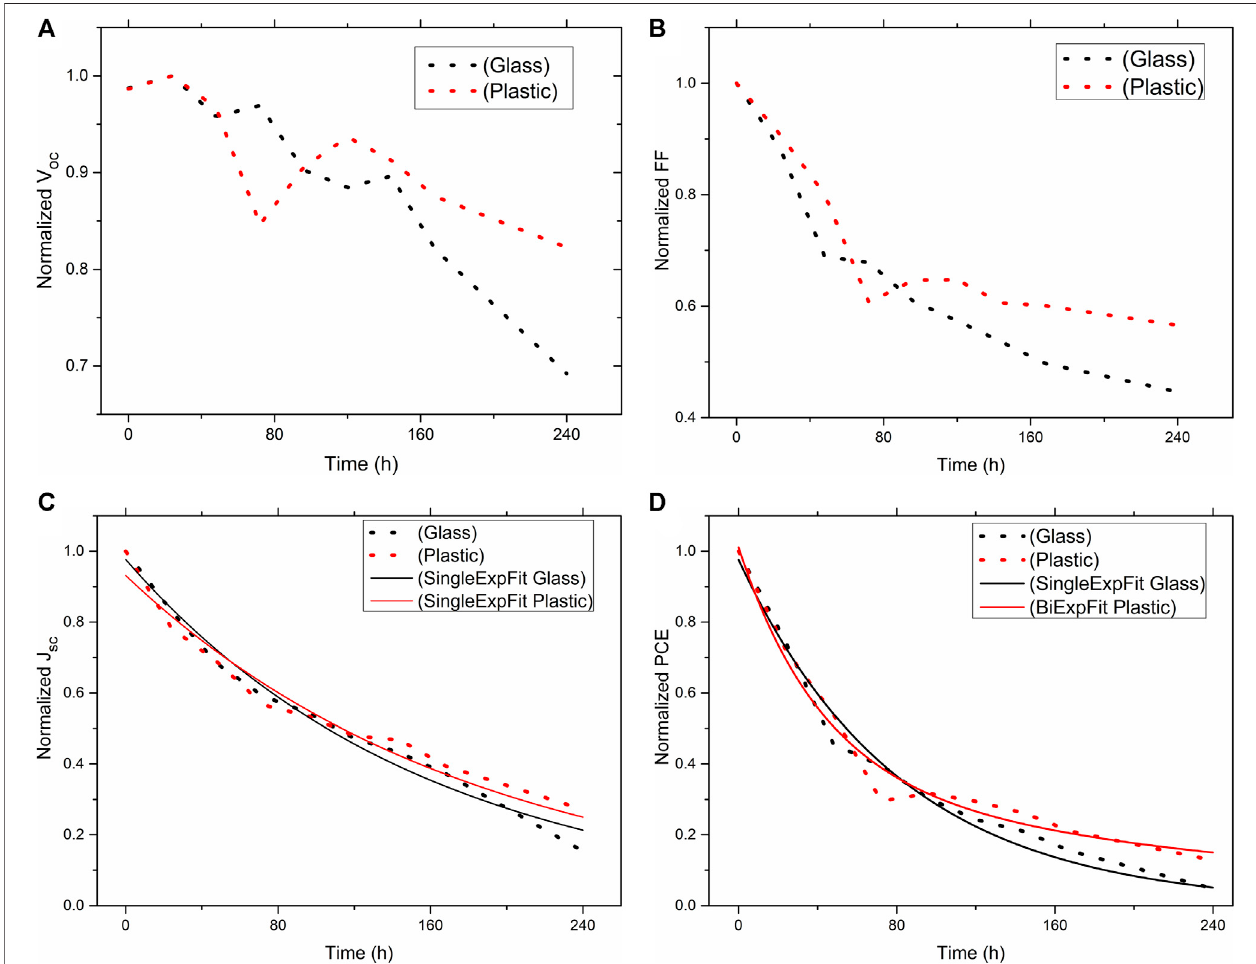
FIGURE 3 | Evolution of the OSCs electrical parameters (Voc (A) , FF (B) , Jsc (C) and PCE (D) ) vs. time (glass and plastic encapsulation) for the ISOS-LT-1 test (weathering chamber). For Jsc and PCE, exponential fi tting is superimposed.